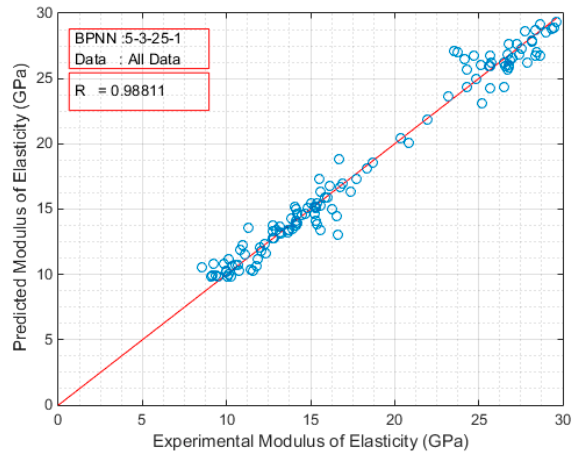
Figure 8. The Pearson’s correlation coefficient R of the experimental and predicted modulus of elasticity for the best with two hidden layers BPNN (5-3-25-1). Sensors 2017 , 17 , 1344